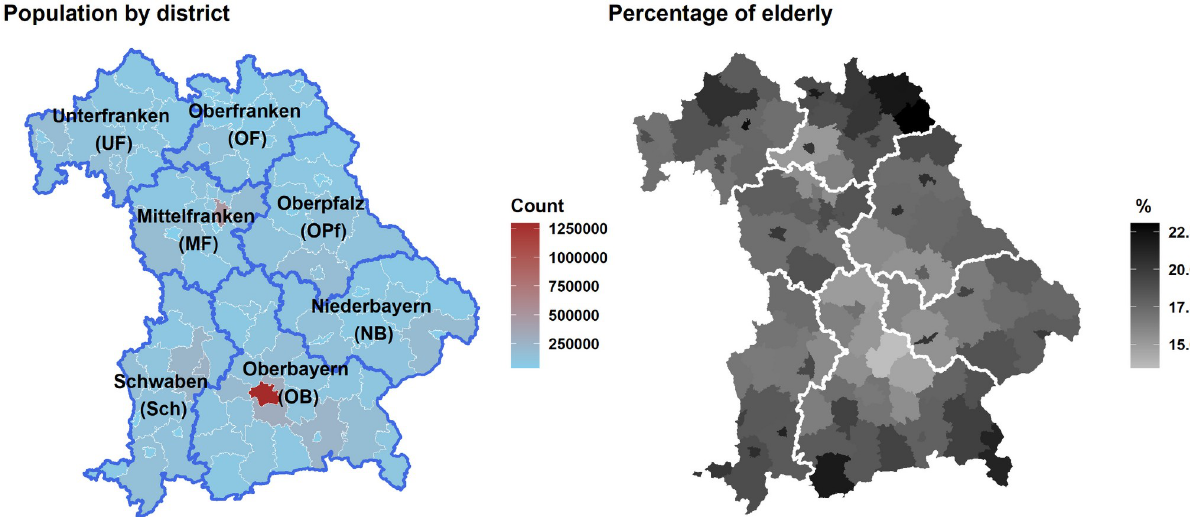
Fig 1. Population of Bavaria. The population in each district (left panel), and the percentage of elderly/senior (right panel). All values are averaged over the study period 1995–2015 [55]. Border shapefiles were provided with written permission by the Bundesamt fu¨r Kartographie und Geoda¨sie under the license (CC BY